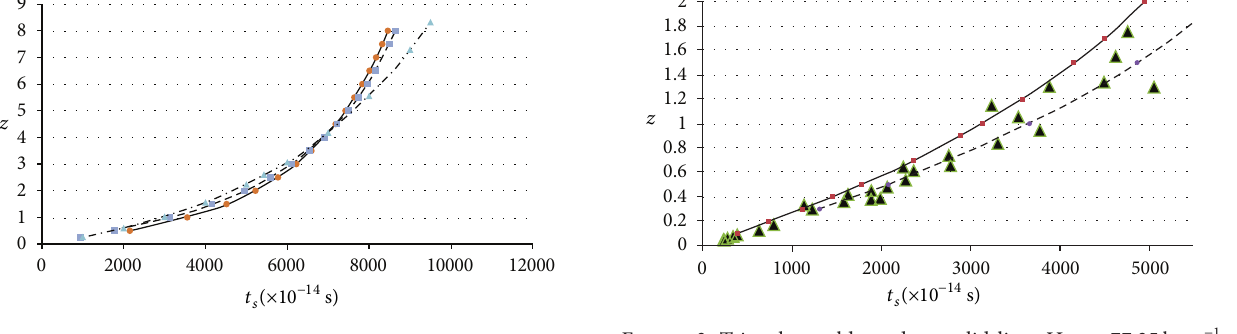
Figure 2: Logarithmic best-fit curve (solid line), Λ CDM with 𝐻 0 = 77.25 kms −1 Mpc −1 (dashed line), and tired light model with 𝐻 2.35 × 10 −18 Hzs −1 Hz −1 (dot-dashed line).